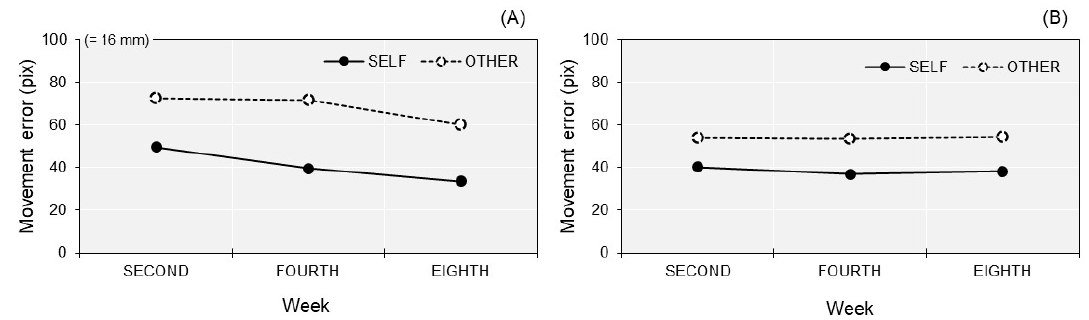
Figure 3. Movement errors in each experiment week (second, fourth, and eighth) for PA ( A ) and PB ( B ). For each condition (SELF and OTHER), the average movement error across cycles was calculated.